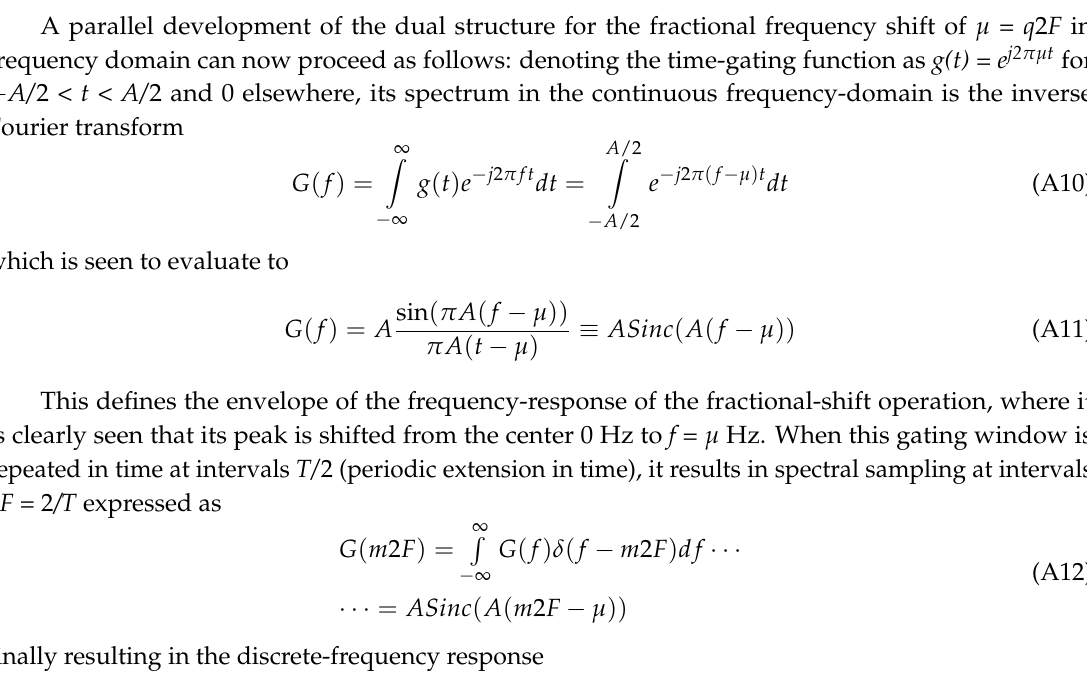
Figure A5. Direct realization of band-limited fractional-delay filter [19].